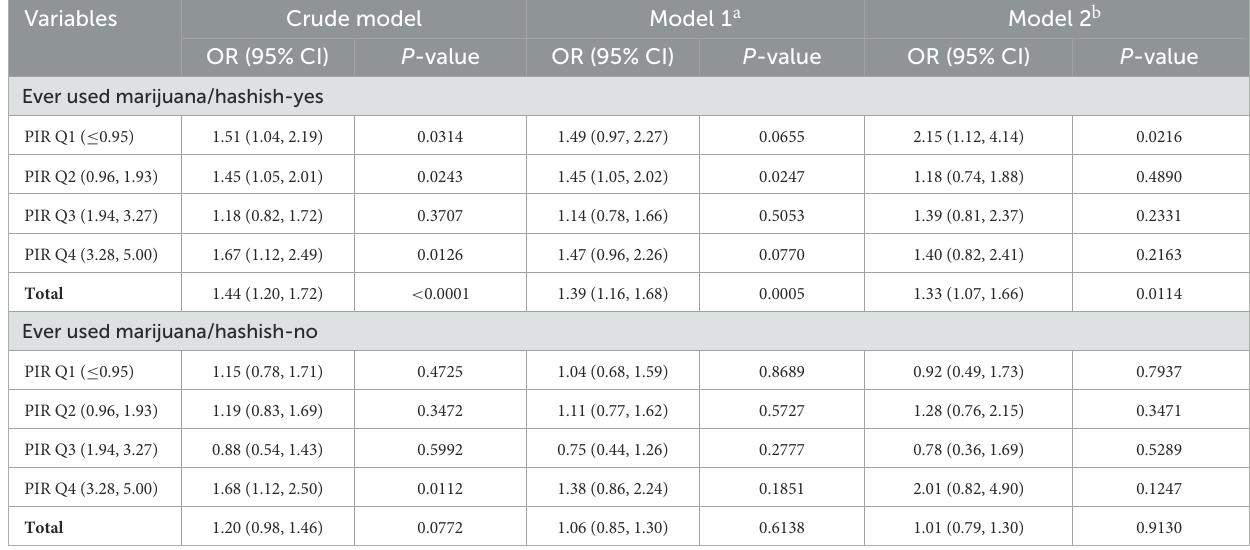
TABLE 3 Comparison of risk of infertility following chlamydial infection in subgroups of women stratified by PIR and ever marijuana/hashish use. Variables